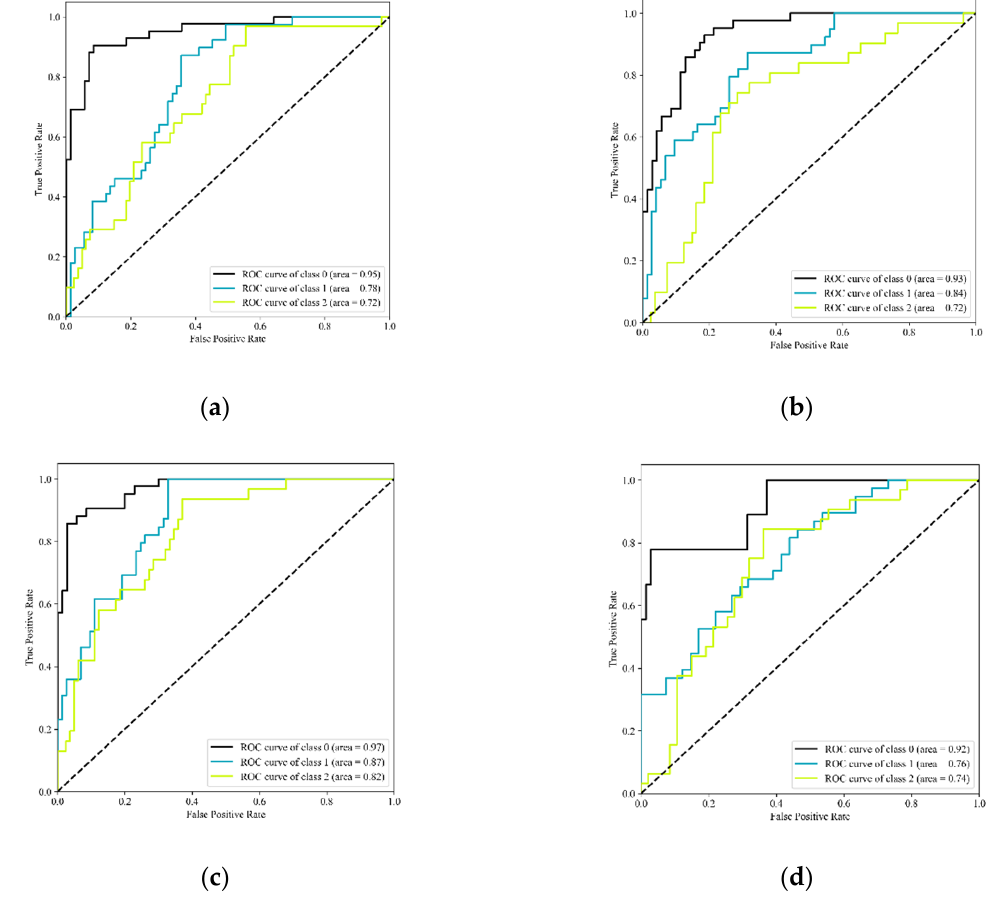
Figure 12. ROC and AUC of different machine learning methods: ( a ) ANN; ( b ) NB; ( c ) XGBoost; ( d ) XGBoost_NoSmote. Table 3. Evaluation measures of different models.